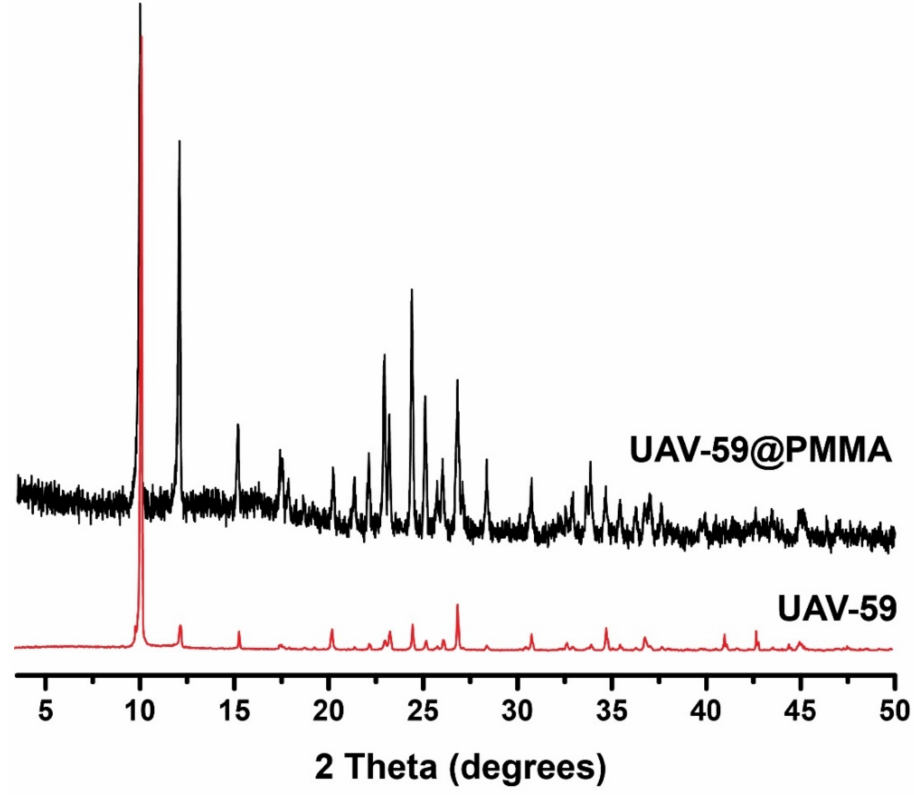
Figure 2. Comparison of the powder X-ray diffraction patterns of powdered UAV-59 and supported in the PMMA matrix